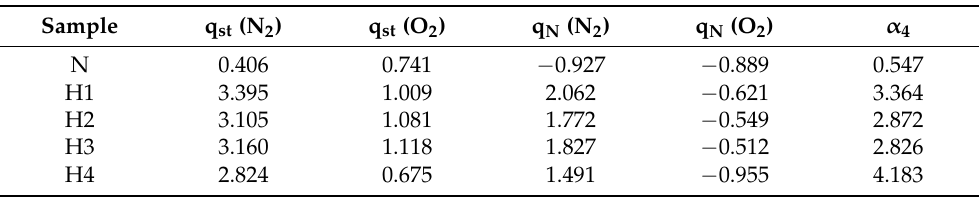
Table 8. Isosteric enthalpies of adsorption (qst, Kcal/mol), net heat of adsorption (q N, Kcal/mol) and selectivity coefficients ( α 4 ) for N 2 and O 2 .